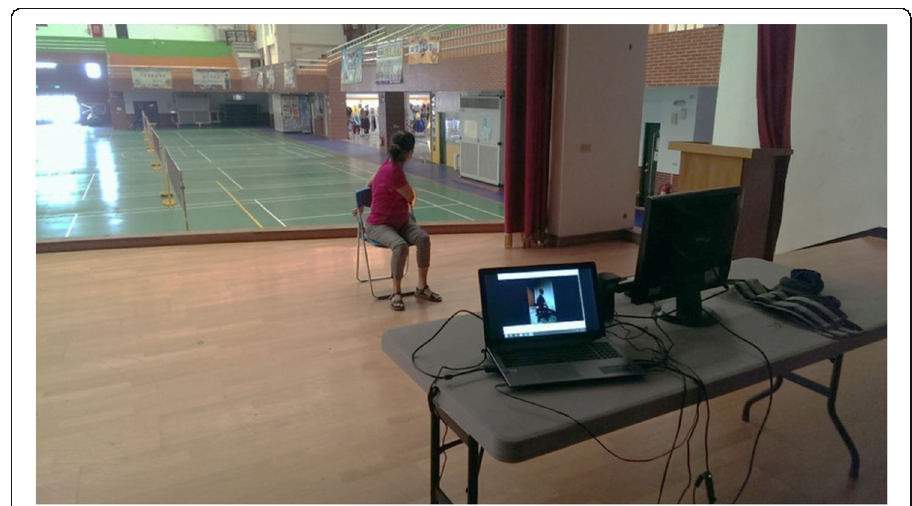
Fig. 13 Executing the cooldown exercise